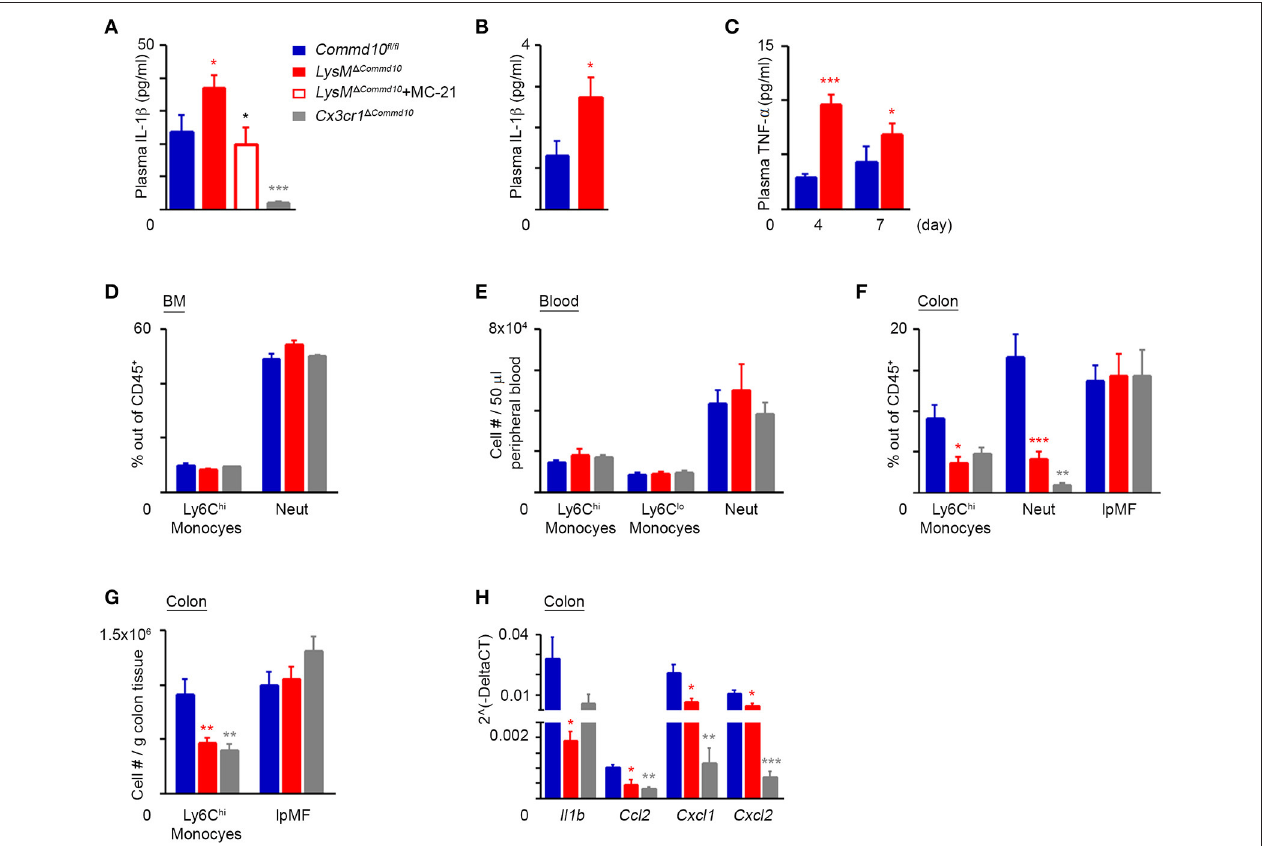
FIGURE 6 | COMMD10 negatively regulates inflammasome activity in Ly6C hi monocytes during colitis. Commd10 fl / fl (blue), LysM 1 Commd 10 (red) or Cx3cr1 1 Commd 10 (gray) mice were treated with DSS (1.5% in drinking water) for 4 or 7 days. Where indicated, MC-21 was injected every day, starting at 24h after DSS administration (red border). (A) ELISA analysis of plasma IL-1 β at day 4 and (B) day 7 of DSS ( n ≥ 5). (C) ELISA analysis of plasma TNF- α (n ≥ 4). (D) Flow cytometry-based assessment of BM Ly6C hi monocyte and neutrophil fractions out of total CD45 + immune cells at day 4 of DSS ( n ≥ 5). (E) Flow cytometry-based assessment of Ly6C hi and Ly6C lo monoyctes and neutrophils in 50 µ l peripheral blood at day 4 of DSS ( n = 6). (F) Flow cytometry-based assessment of colonic Ly6C hi monocyte, neutrophil and resident lpMF fractions out of total CD45 + immune cells at day 4 of DSS ( n = 6). (G) Flow cytometry-based assessment of colonic Ly6C hi monocyte and resident lpMF abundance normalized to tissue mass at day 4 of DSS ( n ≥ 10). (H) qRT-PCR gene expression of Il1b , Ccl2, Cxcl1 , and Cxcl2 in colon tissue at day 4 of DSS ( n ≥ 4). Data were analyzed by unpaired, two-tailed t- test, comparing each time between one of the mouse groups with Commd10 fl / fl mice (colored stars), or between LysM 1 Commd 10 mice with and without MC-21 treatment (black stars). Results are presented as mean ± SEM with significance: * p < 0.05, ** p < 0.01, *** p < 0.001. Data in (A,C,F–H) represent two independent experiments. Data in (D and E) represent a single